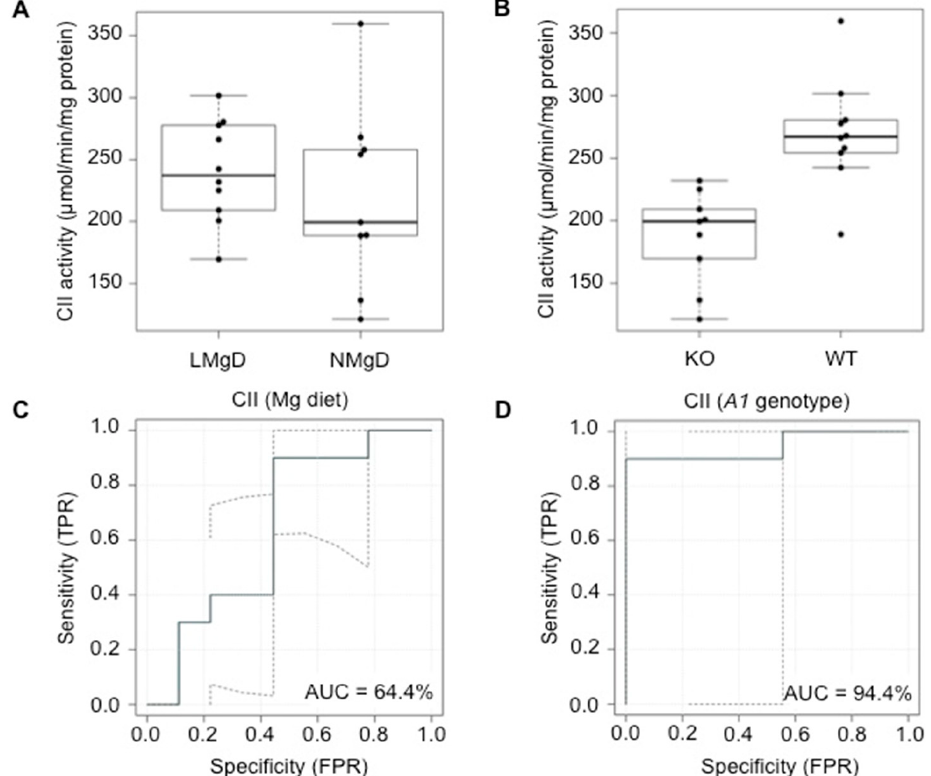
Figure 5. Impact of dietary Mg content and Slc41a1 genotype on the activity of complex II (CII) in murine cardiac mitochondria. ( A ) Box-and-whisker plot overlaid with dot plot showing the influence of dietary Mg content (LMgD vs. NMgD) and ( B ) Slc41a1 genotype ( Slc41a1 − / − vs. Slc41a1 +/+ ) on CII activity in murine mitochondria. For both, A and B, the original source data and corresponding medians are indicated for each group. ( C , D ) Empirical ROC (receiver operating characteristic) curves with the area under the ROC curve (AUC) for ( C ) the type of Mg diet as predictor of CII activity and ( D ) the Slc41a1 genotype as predictor of CII activity. Abbreviations: A1 , Slc41a1 ; FPR, false-positive rate; KO, knock-out; TPR, true-positive rate; WT, wild-type.